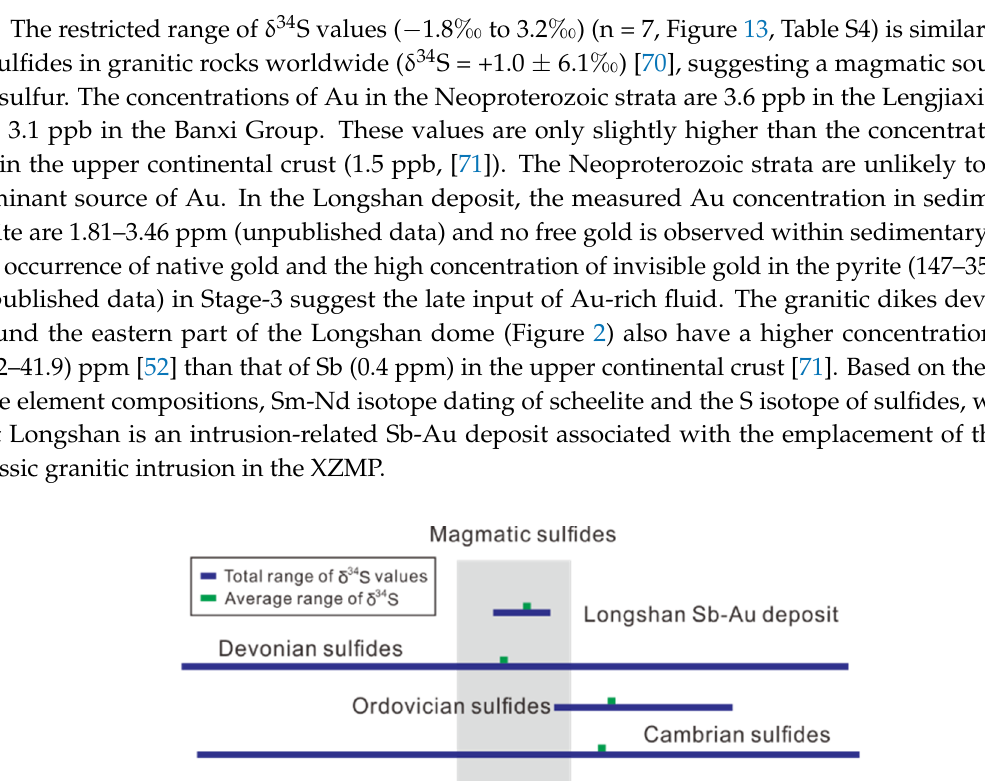
Table S1: Sample information from the Longshan Sb-Au deposit, South China, Table S2: Average minimum detection limits and dwell time for scheelite LA-ICP-MS spot analyses from the Longshan Sb-Au deposit, South China, Table S3: Results of scheelite Sm-Nd and Sr isotopic analysis from the Longshan Sb-Au deposit, South China, Table S4: Sulfur isotope composition of sulfides from the Longshan Sb-Au deposit, South